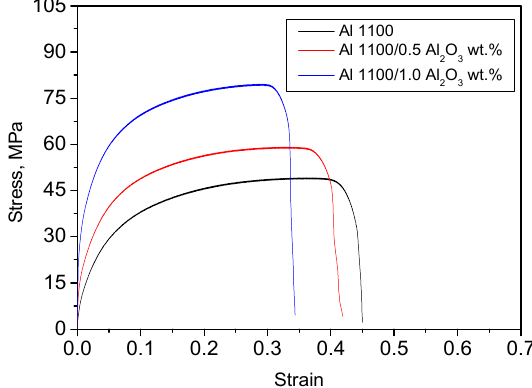
Figure 4. Stress–strain curves obtained for the tensile test samples from investigated alloys: Al 1100: Initial state; Al 1100 / 0.5 wt.% Al 2 O 3 ; Al 1100 / 1 wt.% Al 2 O 3 .